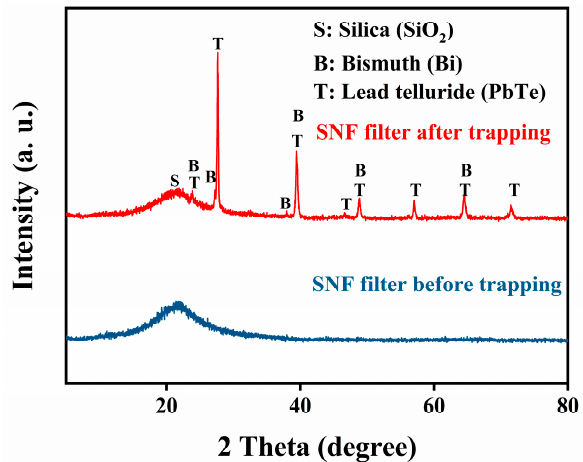
Figure 2. X-ray diffraction (XRD) patterns of the unused SiO 2 nanofibers and the LBE-Te@SiO 2 nan- ofibers.